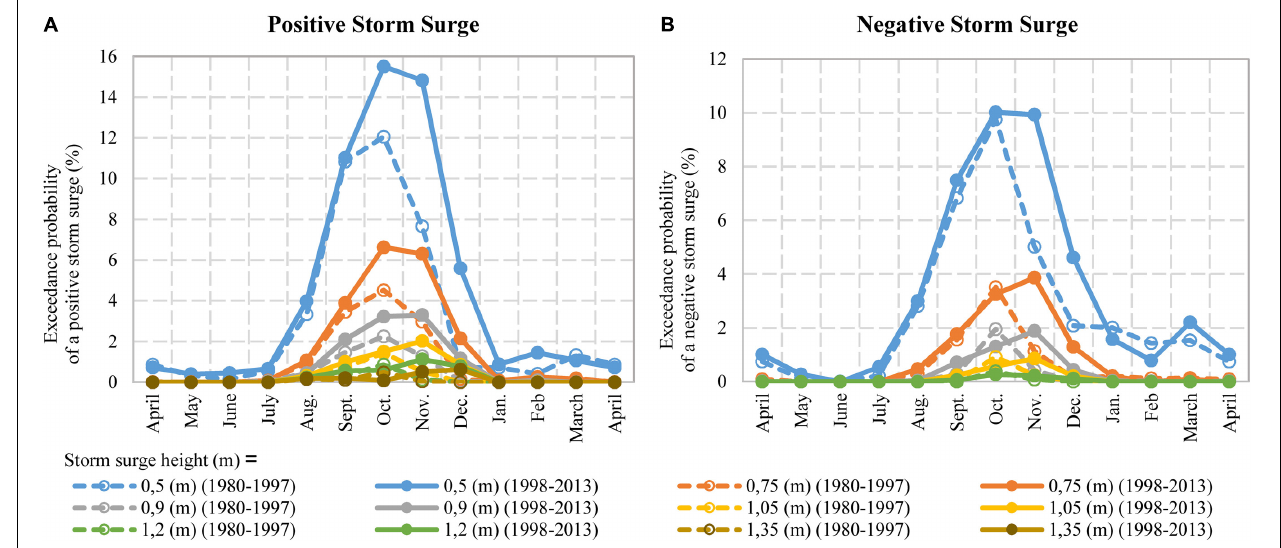
FIGURE 5 | Comparison of exceedance probability of positive (A) and negative (B) storm surge in Rupert Bay for 1980–1997 and 1998–2013 periods adapted from Taha et al. (2017).